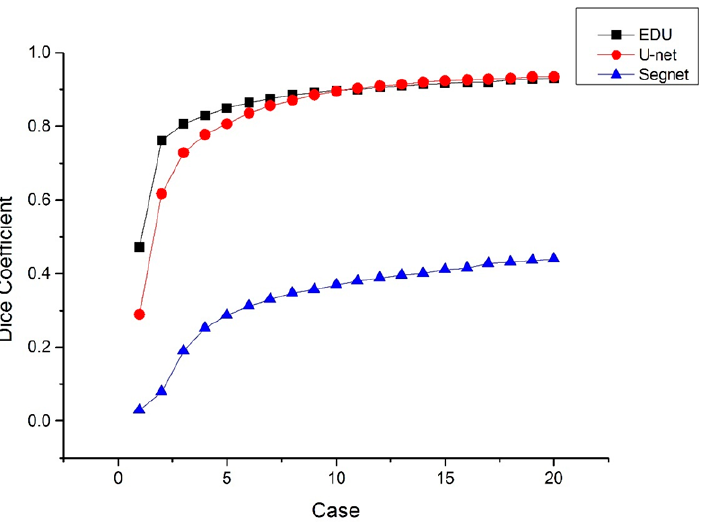
Figure 9. Dice Coefficient comparison from three cases by U-Net, Segnet, and EDU.